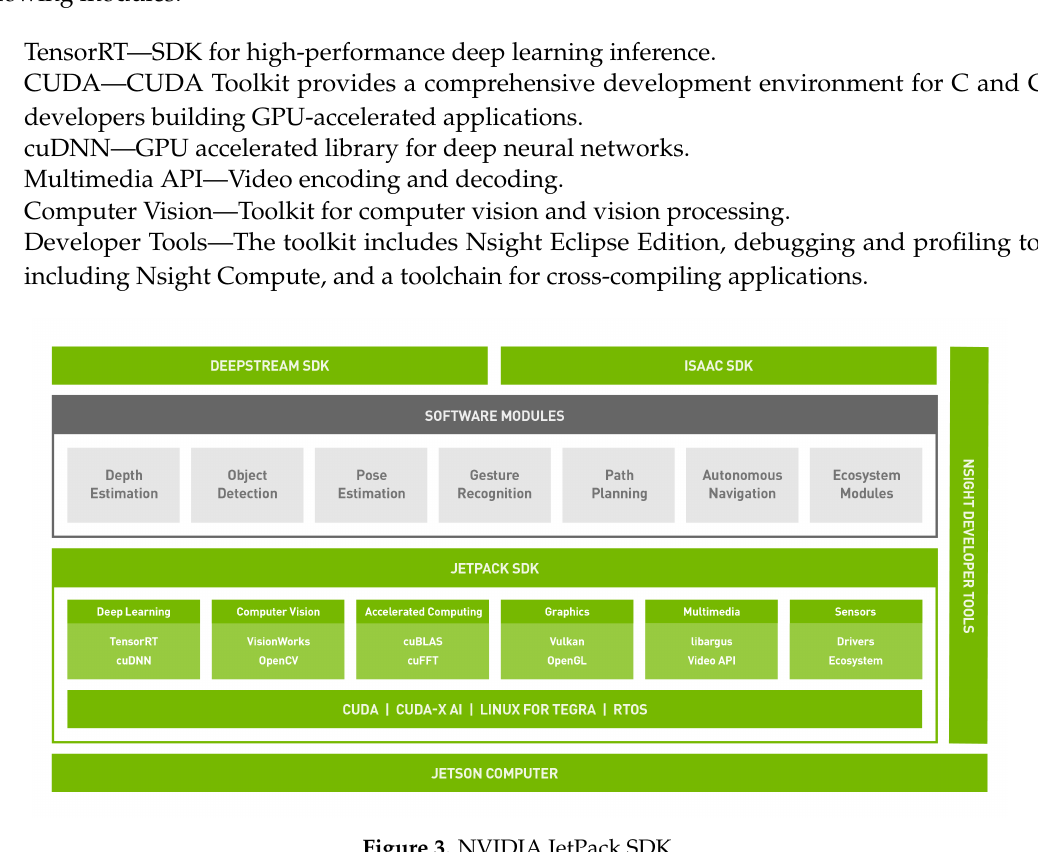
Figure 3. NVIDIA JetPack